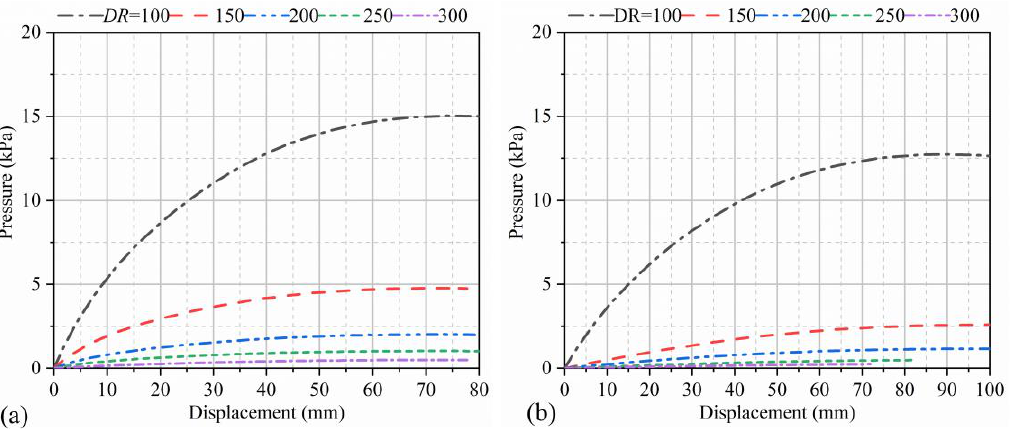
Figure 7. The pressure–displacement curves of FIPP liner with different DR under ( a ) a / R = 0.99; ( b ) a / R = 0.98.